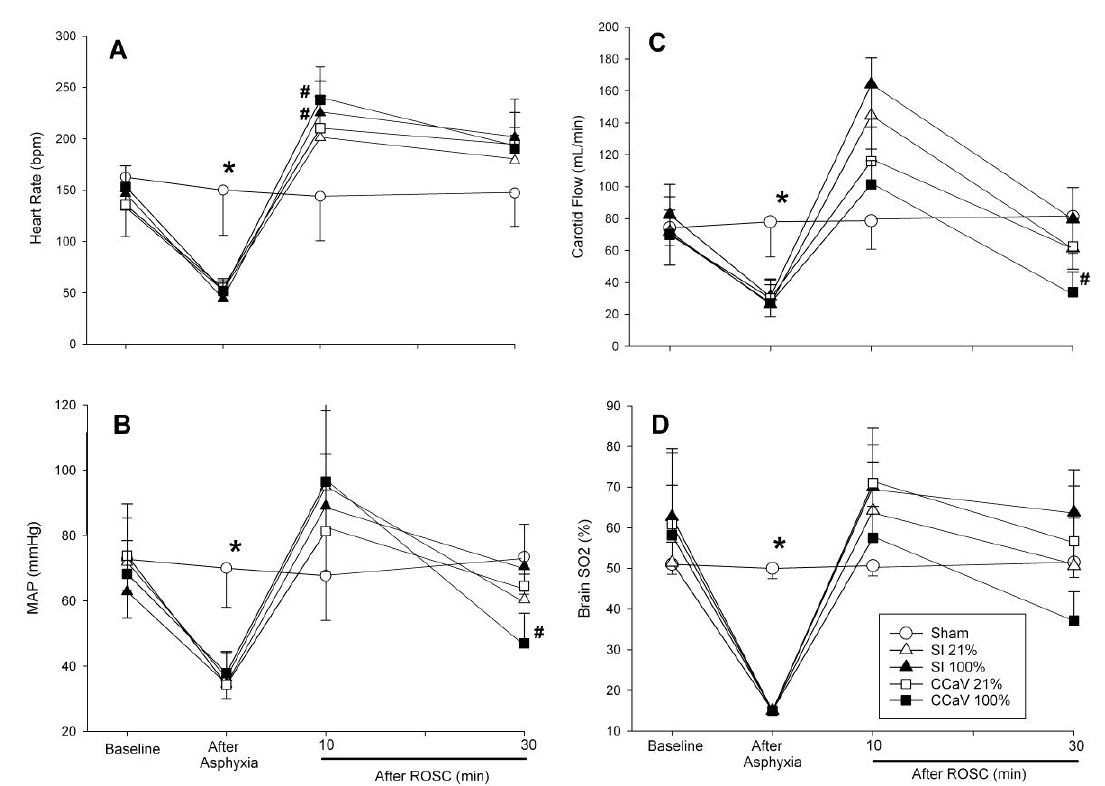
Figure 2. Changes in heart rate ( A ), mean arterial blood pressure ( B ), carotid blood flow ( C ), and cerebral oxygenation ( D ) with 21% and 100% O 2 during continuous chest compression during sustained inflation (CC + SI), continuous chest compression with asynchronized ventilation (CCaV). * Significantly different from all intervention groups, # significantly different from sham-operated group at the same time point. Table 4. Respiratory Parameters during the duration of Chest Compression.